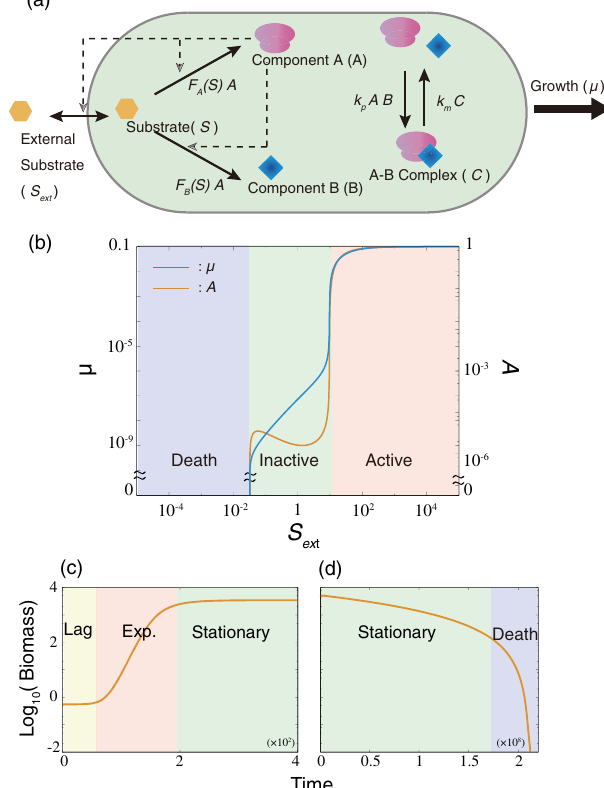
FIG. 1. (a) Schematic representation of the components and reactions in the present model. The concentration of each chemical changes according to the listed reactions. In addition, chemicals are spontaneously degraded at a low rate, and they become diluted because of the volume expansion of the cell. (b) Steady growth rate and the concentration of component A are plotted as functions of the external concentration of the substrate. (c,d) Growth curve of the model. Parameters are set as follows: v 10 − 12 . The detailed numerical method for panels (c) and d C ¼ (d) is given in Appendix